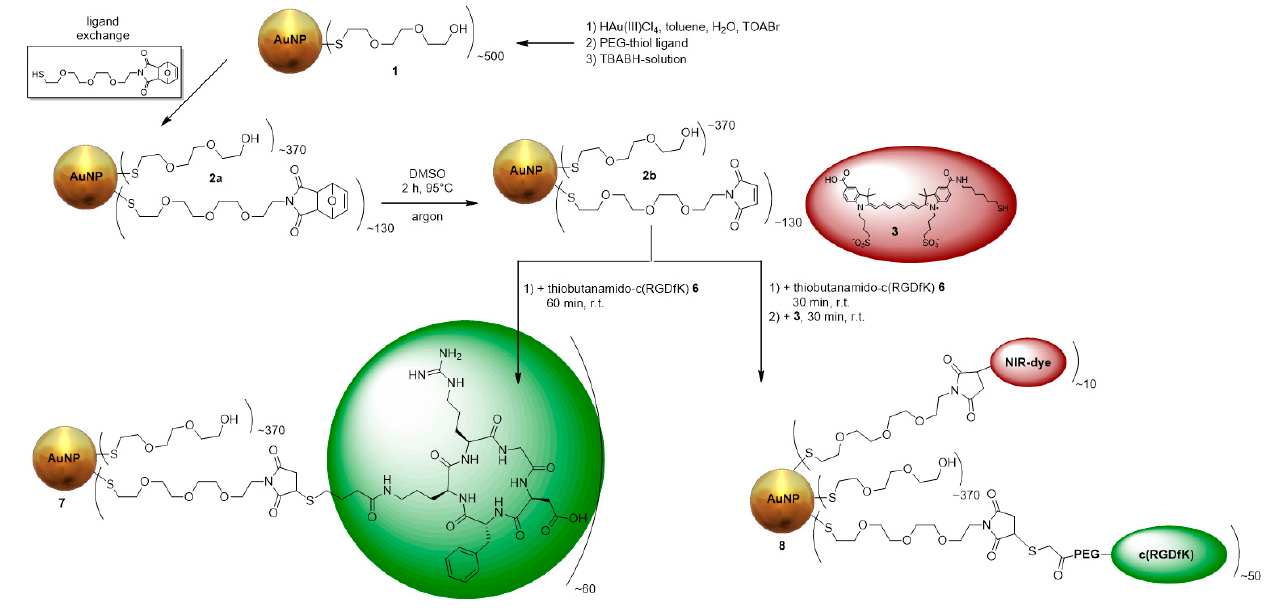
Figure 1. Synthesis of the different RGD-functionalized AuNPs 7 and 8 .